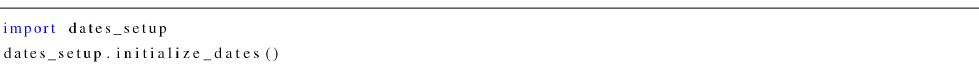
Figure 5. Initializing the DATeS